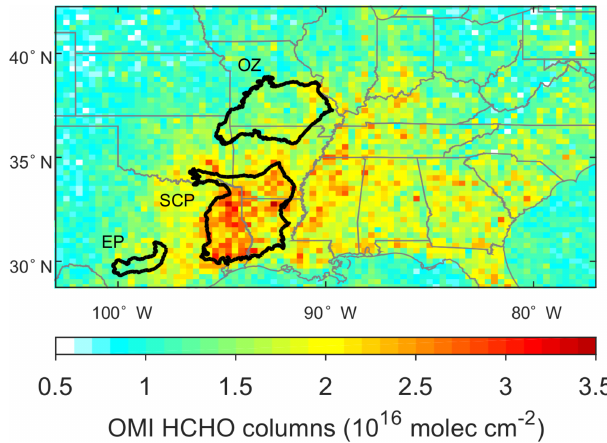
Figure 1. Error-weighted mean OMI HCHO vertical column den- sities for the SEAC 4 RS time period (1 August 2013 – 25 Septem- ber 2013). The Edwards Plateau (EP), Ozarks (OZ), and South Cen- tral Plains (SCP) ecoregions are denoted by black outlines (https: //www.epa.gov/eco-research/ecoregions, level 3 and 4